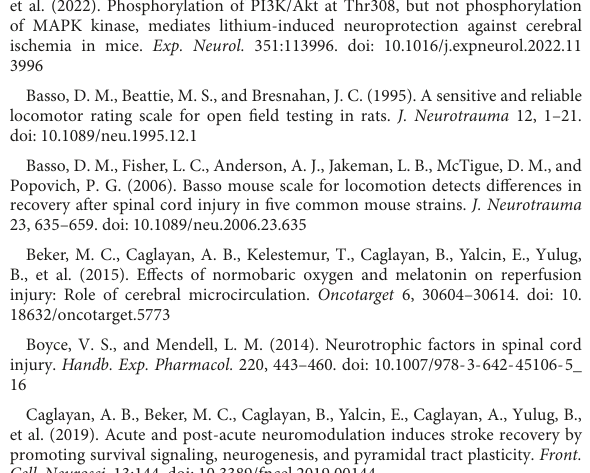
SUPPLEMENTARYFIGURE1 Schematic representation of experimental design. SUPPLEMENTARYFIGURE2 Lithium does not influence reactive astrogliosis of the white matter. Reactive astrogliosis in (A,D) the dorsal funiculus, (B,E) the lateral funiculus, and (C,F) the ventral funiculus of the spinal cord assessed by GFAP immunohistochemistry at (A–C) the rostrocaudal level above the hemitransection (“Rostral level”) and (D–F) the rostrocaudal level below the hemitransection (“Caudal level”) of SCI mice, which were treated with vehicle or lithium (0.2 or 2 mmol/kg/day) for 56 days. Representative GFAP stainings are also shown. Data are mean ± SD values ( n = 16 animals/group). No significant group differences were detected. Scale bars, 50 µ